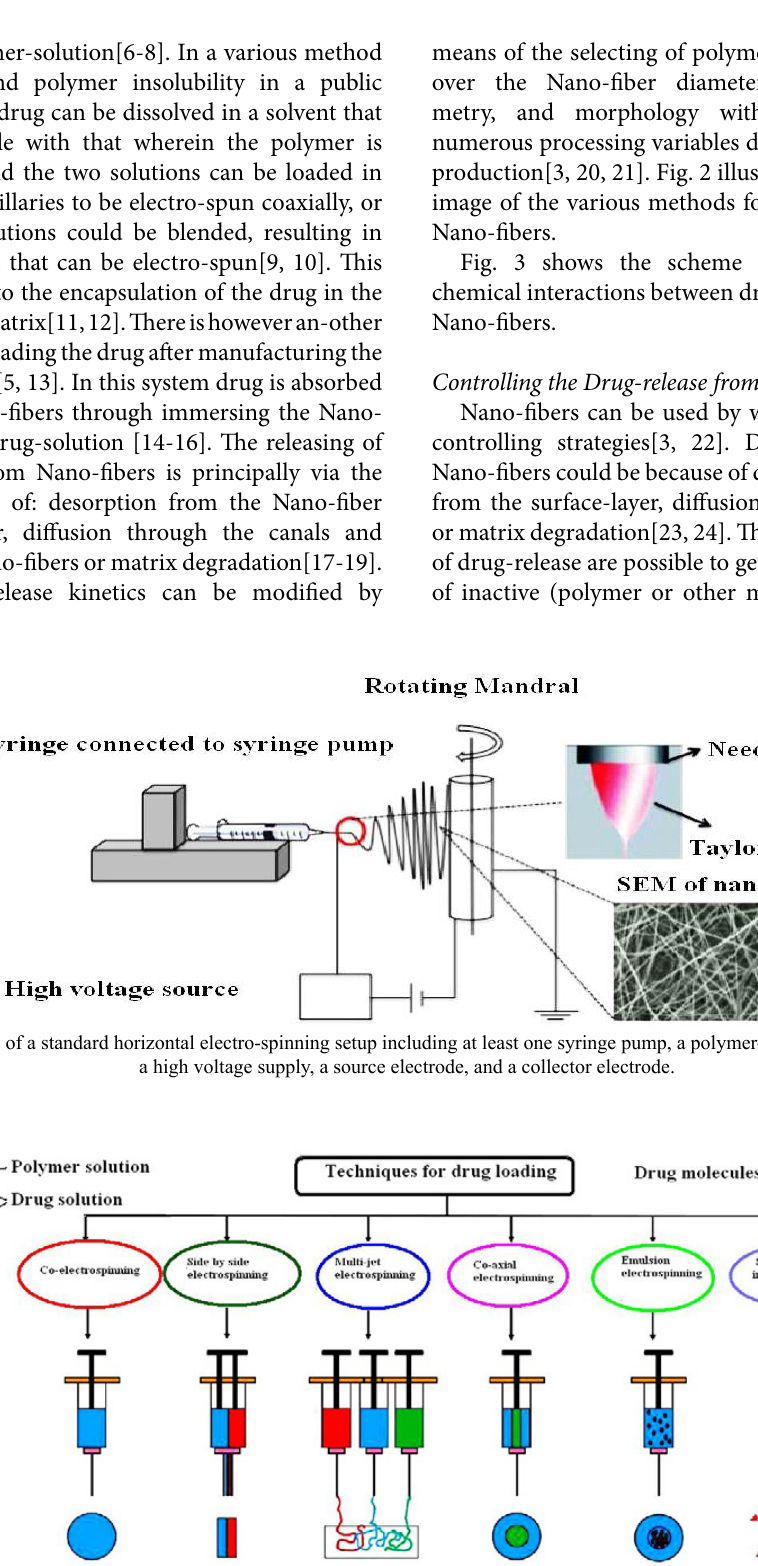
Fig. 2. Techniques for loading drug-molecules in Nano-fibers.